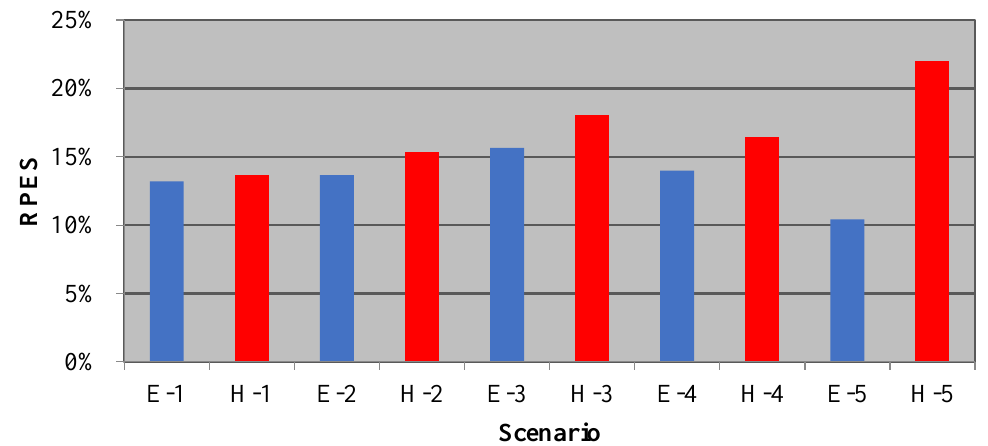
Figure 8. Annual total RPES calculated based on the simulation results for the scenarios.